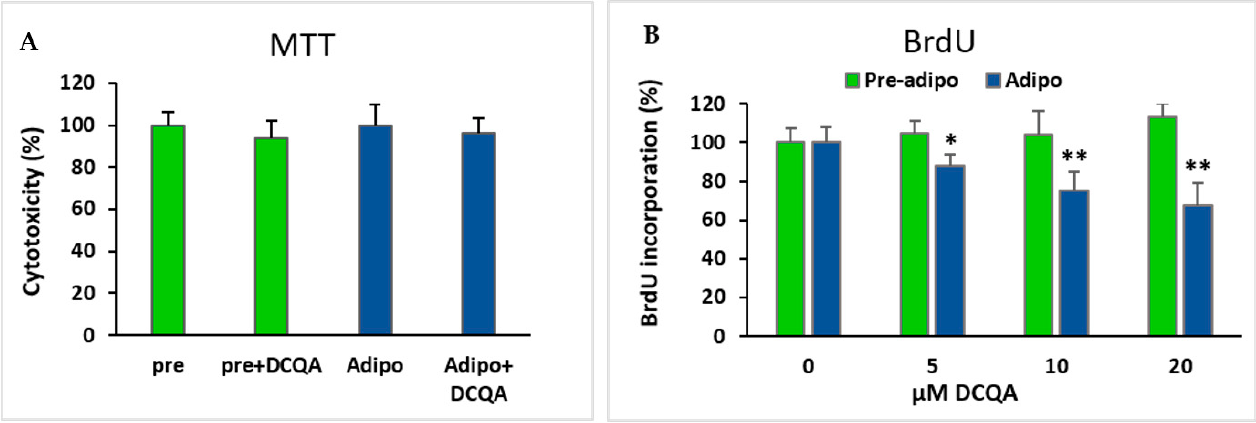
Figure 4. Effect of DCQA treatment on cell viability and cell proliferation ( A ) MTT assay performed after 48 h of treatment with 10 µM DCQA in comparison with control sample. Both pre-adipocytes and 48 h induced adipocytes were compared. Differences are not statistically significant; ( B ) BrdU incorporation assay in not induced (green) and 48 h MDI-induced (blue) 3T3-L1 cells. Cells were treated with 0, 5, 10 or 20 µM DCQA for 48 h. At the end of treatment BrdU incorporation assay did not show any significant difference in pre-adipocytes. On the contrary, in MDI-induced cells for 48 h, a dose-dependent reduction of cell proliferation rate was registered (* p < 0.05; ** p < 0.001).